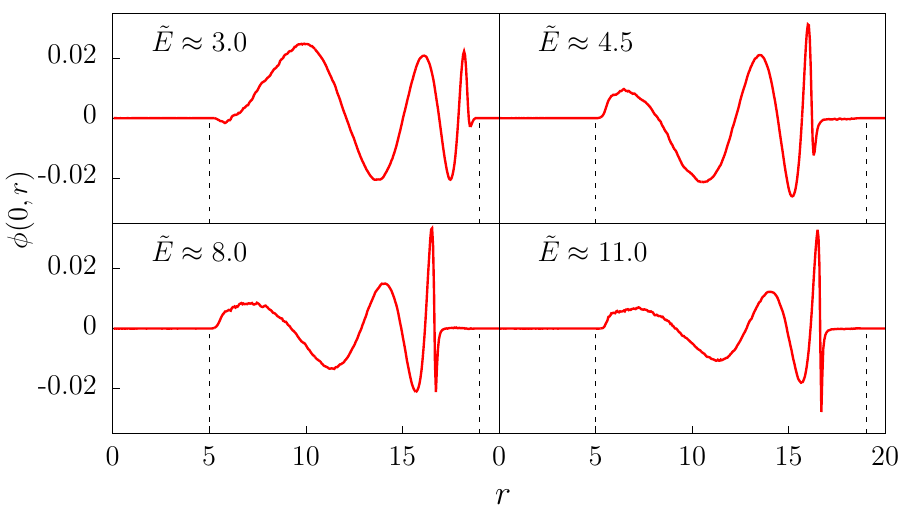
Figure 2 . The (cid:12)eld con(cid:12)gurations (cid:30) ( t = 0 ; r ) of the solutions at the upper boundary with ~ N f = ~ N max ( ~ E ) for ~ E (cid:25) 3 : 0 ; 4 : 5 ; 8 : 0 and 11.0. The space lattice parameters are N r = 400, R = 30. The f dashed lines mark the space interval for the initial wave packet.